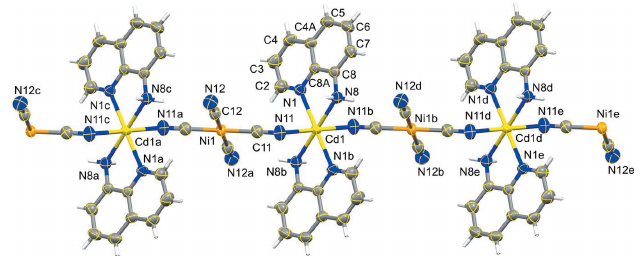
Figure 1 The coordination polymer formed by the title compound. For the sake of clarity many of the C atom labels have been omitted: the atoms marked with a, b, c, d or e are at the symmetry positions (1 (cid:4) x , 1 (cid:4) y , (cid:4) z ), (1 (cid:4) x , 1 (cid:4) y , 1 (cid:4) z ), ( x , y , (cid:4) 1 + z ), ( x , y , 1 + z ) and (1 (cid:4) x , 1 (cid:4) y , 2 (cid:4) z ), respectively,. Displacement ellipsoids are drawn at the 80% probability level.